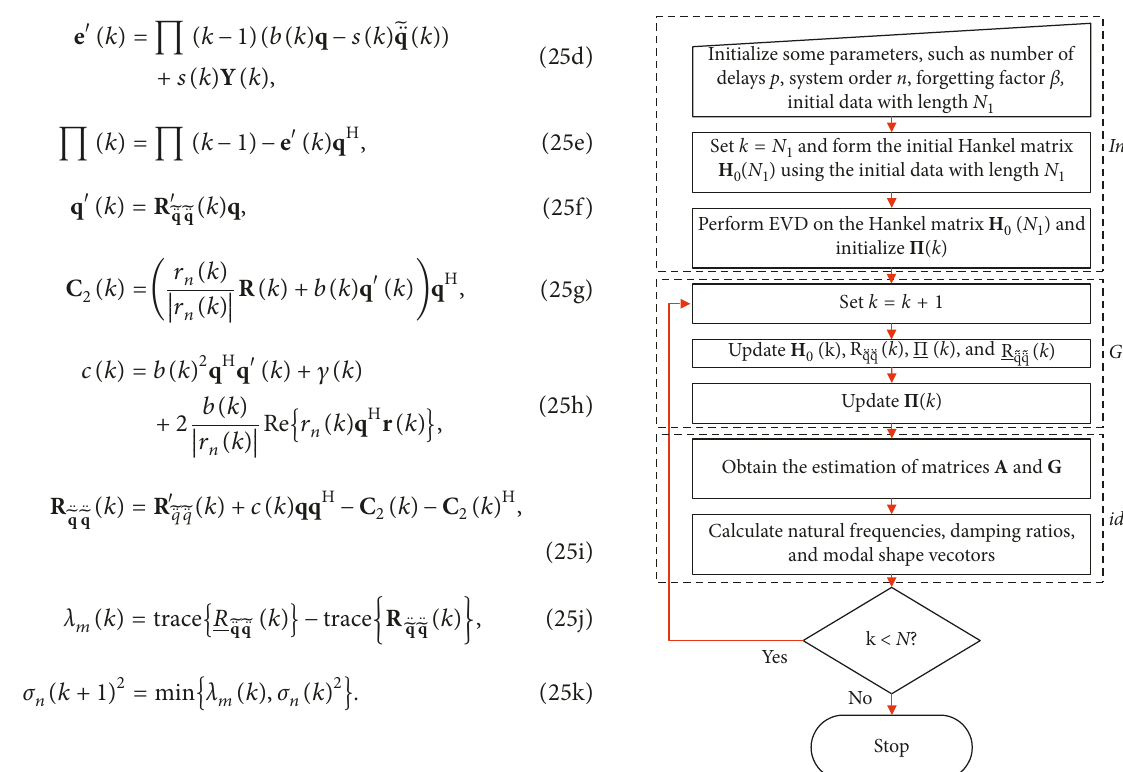
Figure 2: Flowchart of the proposed online modal identification using the GYAST-RSSI method and strong-motion